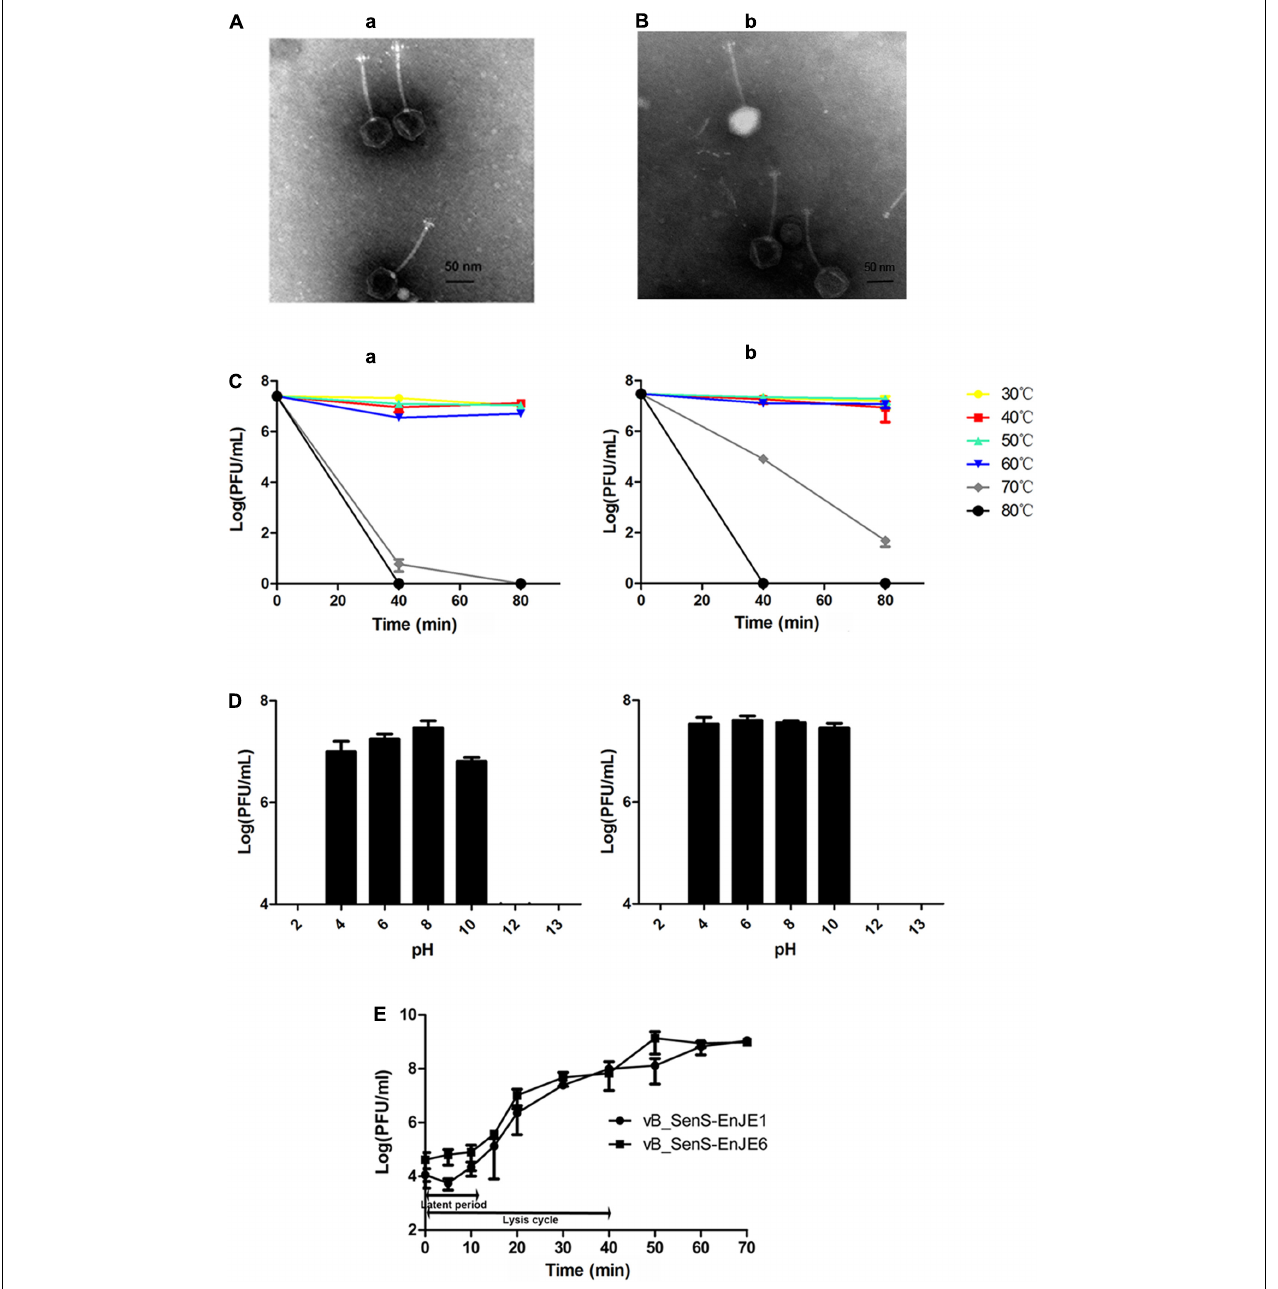
FIGURE 1 | Biological features of phages. Electron microscopy images of vB_SenS-EnJE1 (A) and vB_SenS-EnJE6 (B) . The bar represents 50 nm. (C) Thermal stability of vB_SenS-EnJE1 (a) and vB_SenS-EnJE6 (b). Phage particles were incubated under different temperature conditions, and then, the samples were collected at 40 and 80 min after incubation. (D) pH stability of vB_SenS-EnJE1 (a) and vB_SenS-EnJE6 (b). Phage particles were collected after 1 h of incubation under different pH conditions. The titres of the phages at different pH values and thermal conditions were determined by the double layer agar method. (E) One-step curves of the two phages at MOI = 0.1. All experiments were repeated three